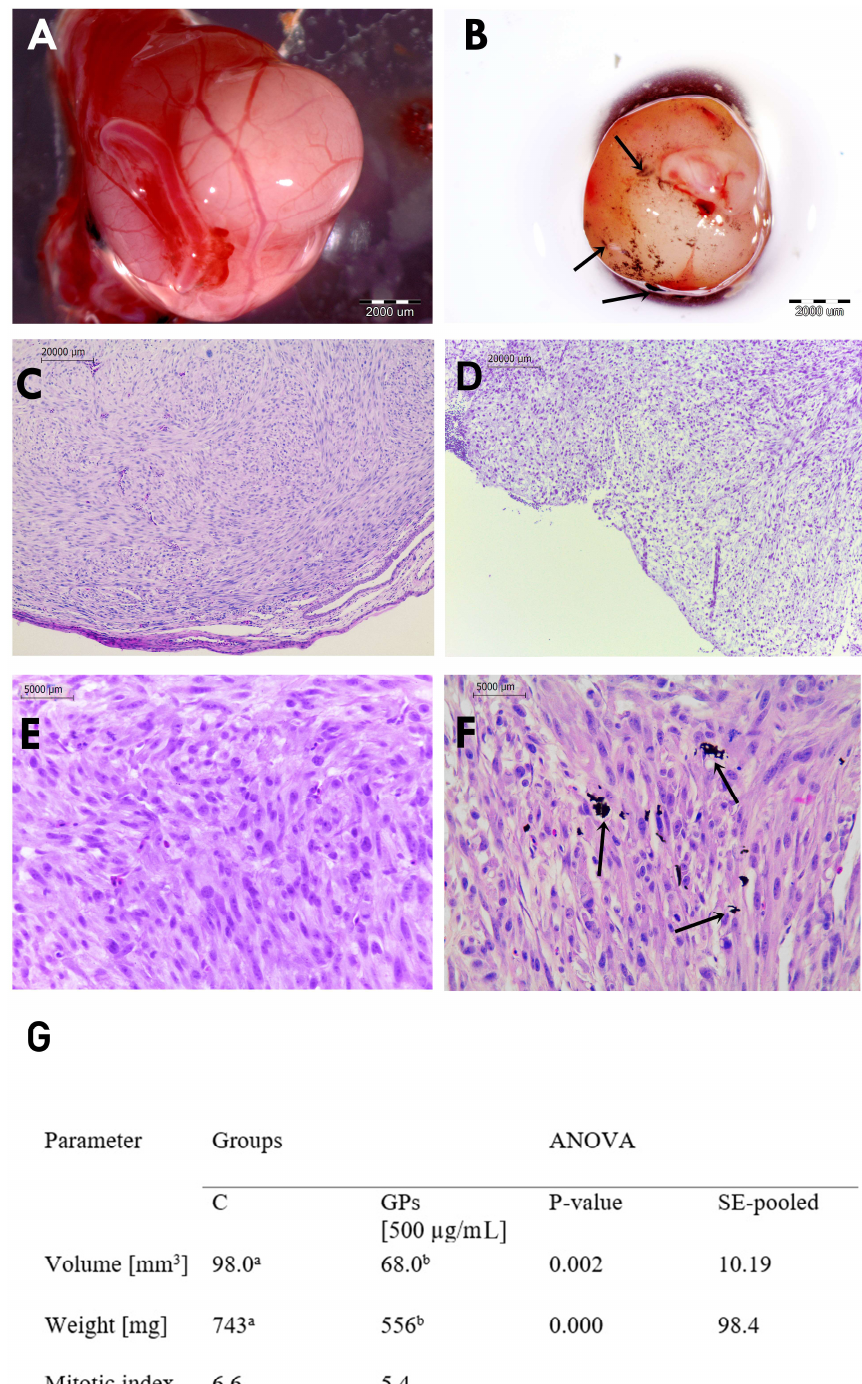
Figure 6. Glioblastoma multiforme tumor cultured on chorioallantoic membrane. ( A , C , E ) control group; ( B , D , F ) pristine graphene treated group. ( G ) U87 tumor volume, weight, and mitotic index in the control ( C ) and pristine graphene (GPs) groups. Notes: Black arrows point to graphene agglomerates. The columns with different letters (a–b) indicate significant differences between the groups.